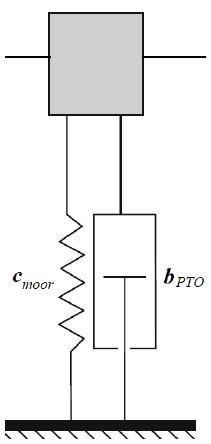
Figure 15. A mechanical system with one degree of freedom.